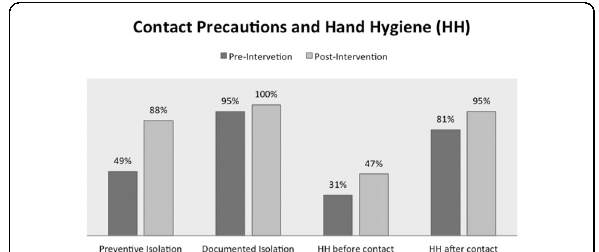
Fig. 1 (abstract 000926). Kaplan Meier plot for ICU mobility status and 28-days